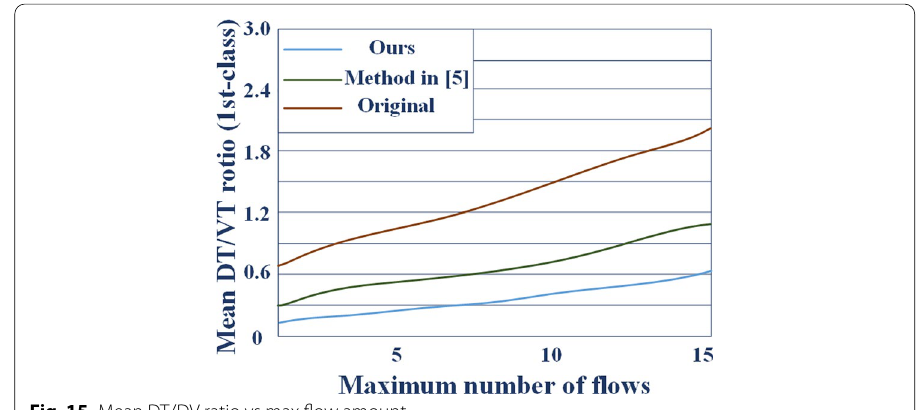
Fig. 15 Mean DT/DV ratio vs max flow amount